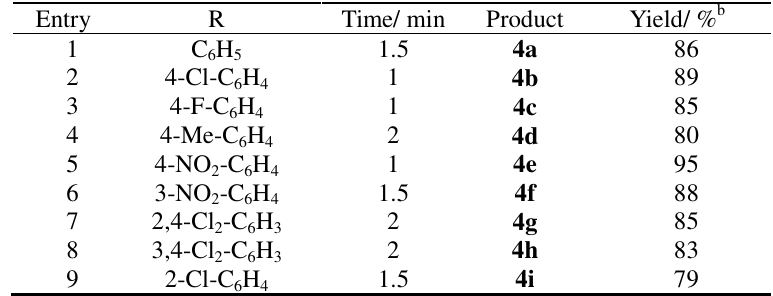
Table 3. Preparation of 10-aryl-6,8-dimethyl-6,10- dihydro-5-oxa-6,8-diazaanthra [2,3- d